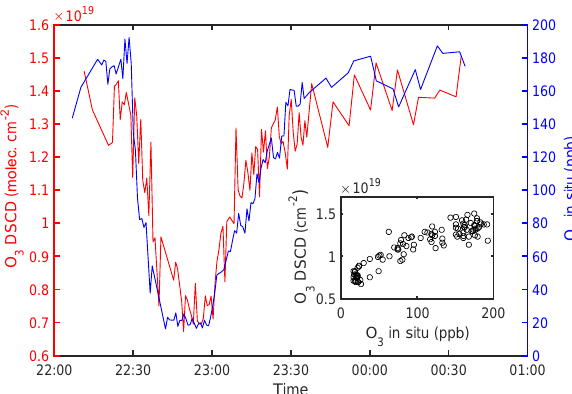
Figure 9. Comparison of limb O 3 DSCD and in situ mixing ratios during the second vertical profile maneuver during SF3-2013. The insert shows the clear correlation between the mini-DOAS observa- tions and the flight-level ozone mixing ratios, which indicates the high sensitivity of the mini-DOAS for O 3 detection at flight